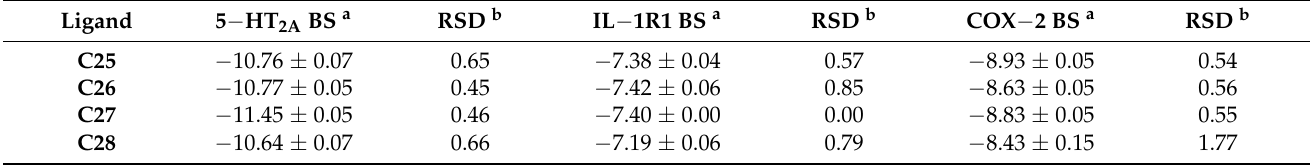
Table 3. Molecular docking results of Group C compounds.